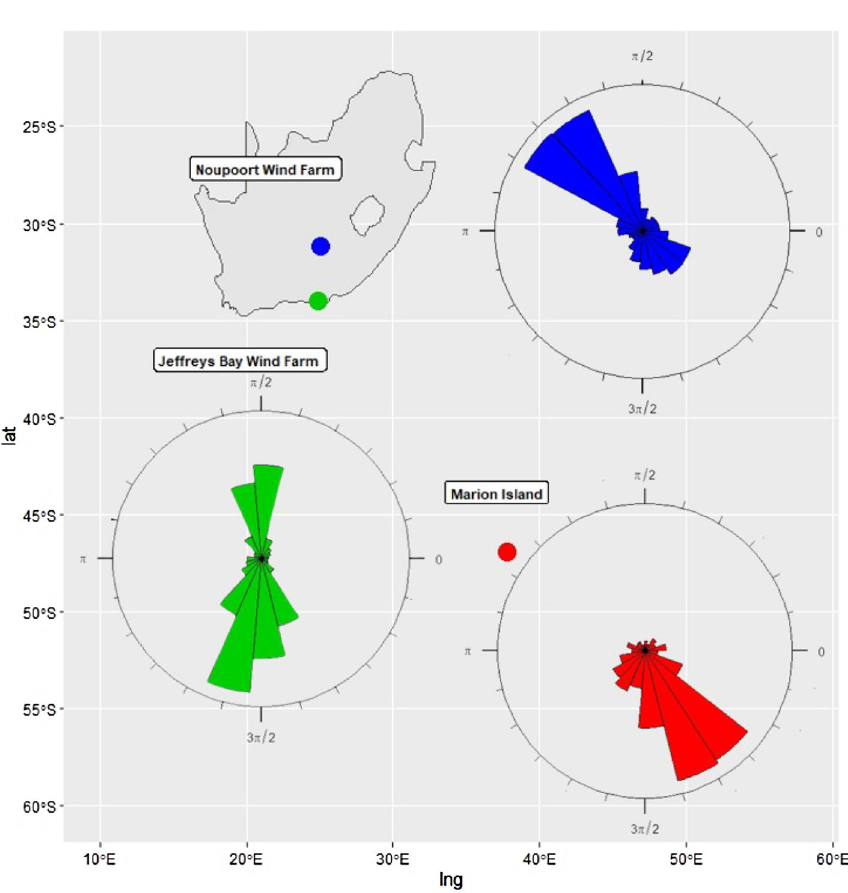
Figure 3. Map of South Africa with the locations of Marion island, Jeffreys Bay and Noupoort wind farms and rose plots of the wind direction (created by R programming language version 4.1.3 https:// www.r- proje ct.